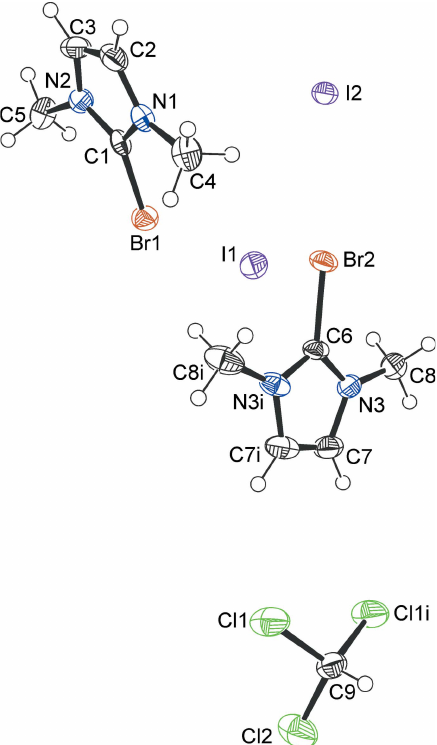
Figure 1 The molecular structure of the chloroform solvate 1 , showing the atom labels and 50% probability displacement ellipsoids for non-H atoms. [Symmetry code: (i) x , 1 (cid:3) y , z .]